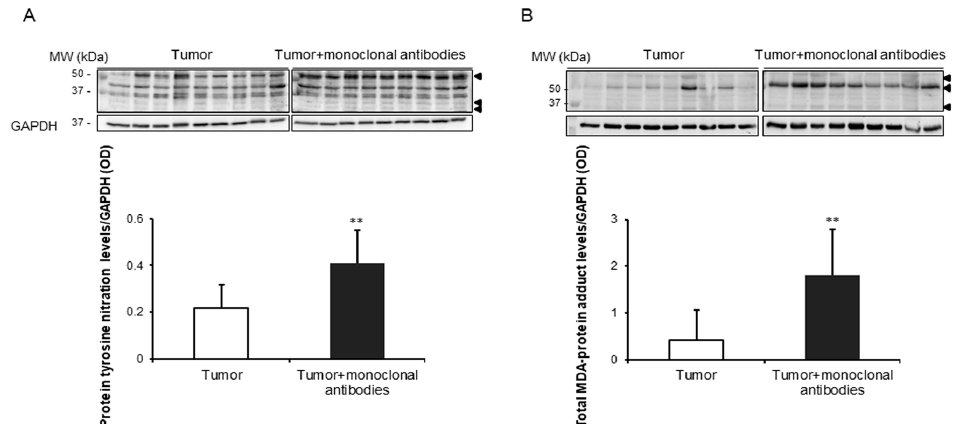
Figure 4. ( A ) Representative immunoblots and mean values and standard deviation of total protein tyrosine nitration levels / GAPDH in subcutaneous tumors of lung cancer mice as measured by optical densities. ( B ) Representative immunoblots and mean values and standard deviation of total MDA protein adduct levels / GAPDH in subcutaneous tumors of lung cancer mice as measured by optical densities. Representative GAPDH is shown as the loading control. Statistical significance is represented as follows: **: p ≤ 0.01 between non-treated controls ( N = 9) in white bars and treated lung cancer ( N = 9) mice in black bars. Definition of abbreviations: MDA, malondialdehyde; GAPDH, glyceraldehyde-3-phospate dehydrogenase; OD, optical